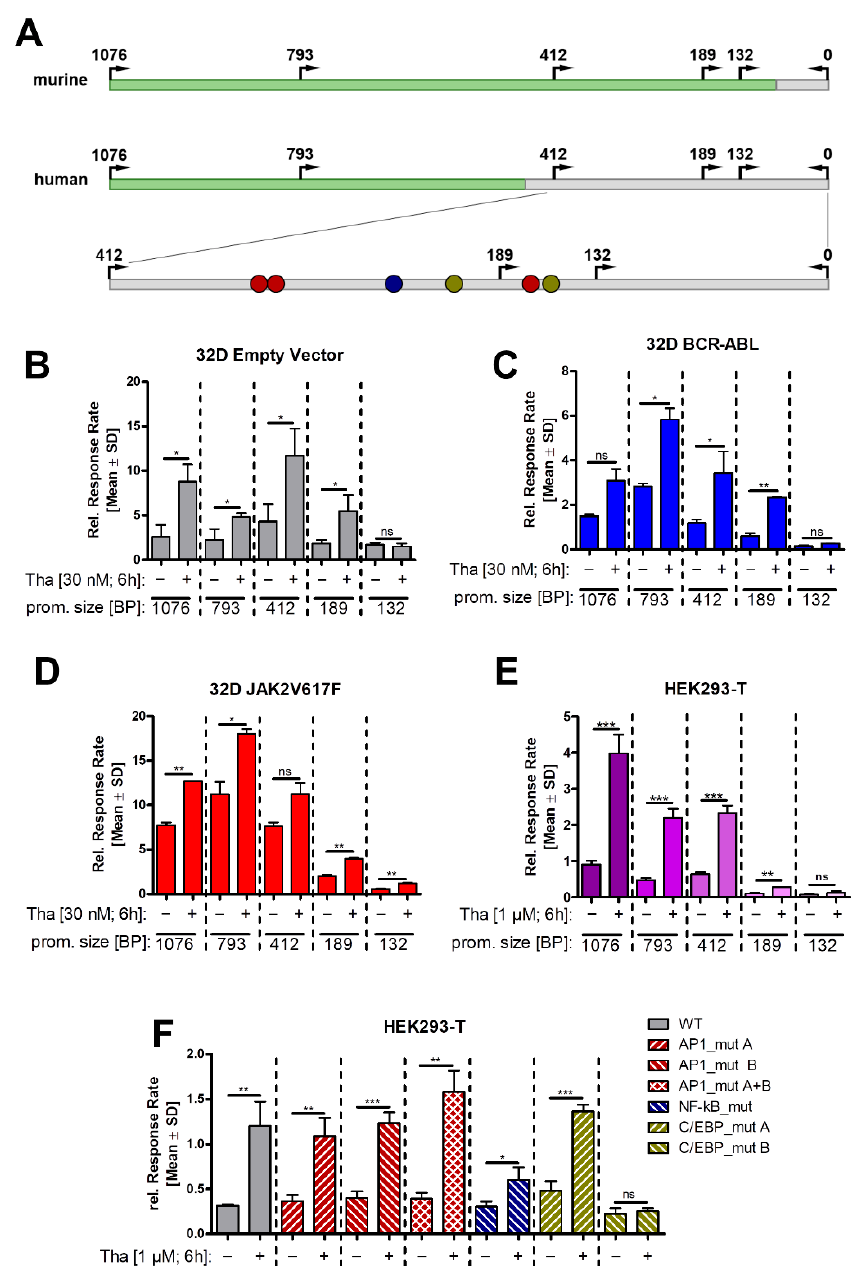
Figure 5. LCN2 promoter activity is induced by UPR activation. ( A ) Schematic representation of the murine and human LCN2 promoter region. Arrows indicate fragment size used in the luciferase assays. green = untranscribed region, grey = untranslated region, red dot = AP1 binding site, blue dot = NF- κ B binding site, yellow dot = C/EBP binding site. ( B – D ) Luciferase assay of 32D cells transfected with pGL3 constructs containing fragments of the murine Lcn2 promoter. Fragment length in base pairs (bp) as depicted in ( A ). Cells were treated with 30 nM Tha for 6 h prior to analysis. n = 3, t -test. ( E ) Luciferase assay of HEK293-T cells using pGL3 constructs containing human LCN2 promoter fragments as depicted in ( A ). Cells were treated with 1 µ M Tha for 6 h prior to analysis. n = 3, t -test. ( F ) Luciferase assay of HEK293-T cells transfected with different mutants of the 412 bp pGL3 construct. Cells were treated with 1 µ M Tha for 6 h prior to analysis. n = 3, t -test. Asterisks indicate p -values of: * = p < 0.05; ** = p < 0.01; *** = p < 0.001. ns – not significant. Next, we transfected human HEK293-T cells with reporter constructs carrying pro- moter fragments similar in size to the murine constructs (Figure 5E). In line with our find-